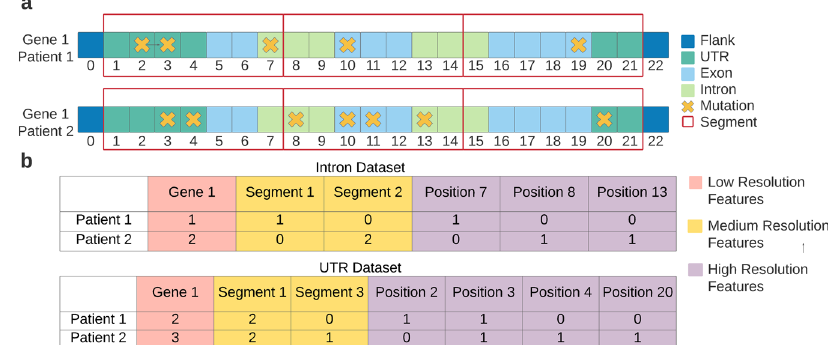
Fig. 3 A simpli fi ed illustration of the feature extraction process. a A representation of the initial genomic information. The X ’ s denote mutations that two patients have in the same gene. The red rectangular frames represent the 50-nucleotide-long segments used for the medium-resolution features. b An example of the features that would have been extracted for the intron dataset and the UTR dataset according to the initial information shown in